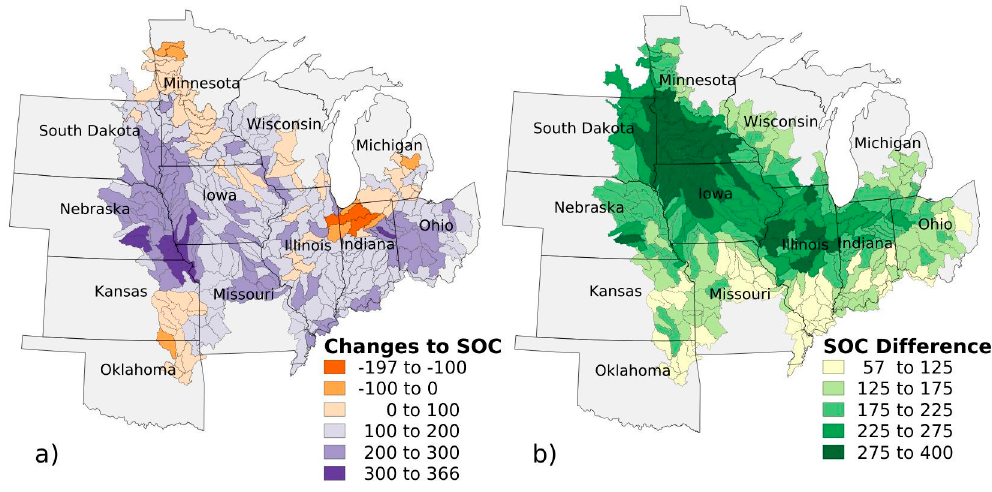
Figure 9. ( a ) Area-weighted mean annual dSOC stock rates (kgC / ha / yr) by HUC 8 from 2005 to 2017 simulated with OpTIS-mapped management practices (negative dSOC values represent a loss of soil organic carbon (SOC)); ( b ) Additional mean annual SOC accumulation (kgC / ha / yr) from OpTIS-mapped management by HUC 8 (compared to no soil health management practices scenario).